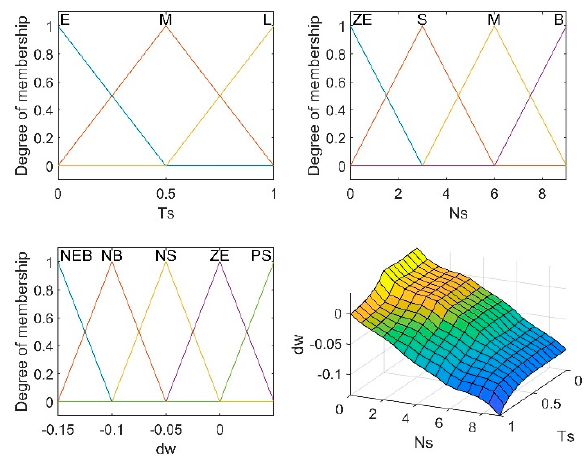
Figure 4. Design of fuzzy inference system for inertia weight tuning.